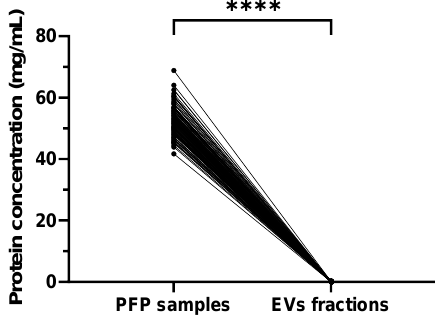
Figure 1. Graph representing the protein concentration before SEC isolation (PFP samples) and after SEC isolation (EV fractions) (n = 130); **** p < 0.0001. The total protein concentration was drastically reduced after isolation of EVs using the SEC method.